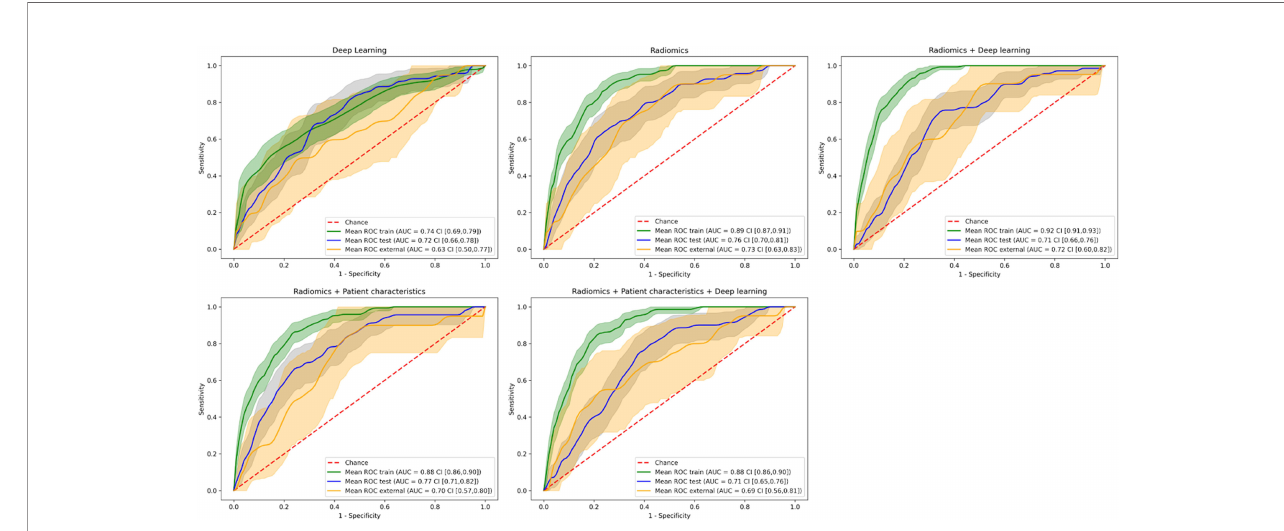
FIGURE 6 | Receiver operating characteristic curves of the training, testing, and external validation datasets for the different model combinations. The shaded areas represent the 95% con fi dence intervals of the corresponding receiver operating characteristic